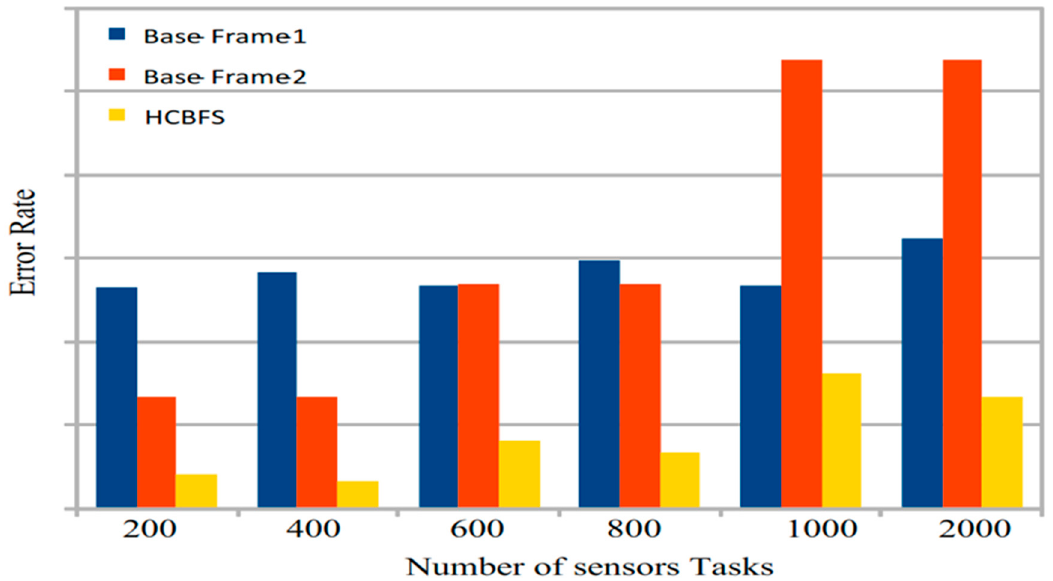
Figure 6. Error rate of task.